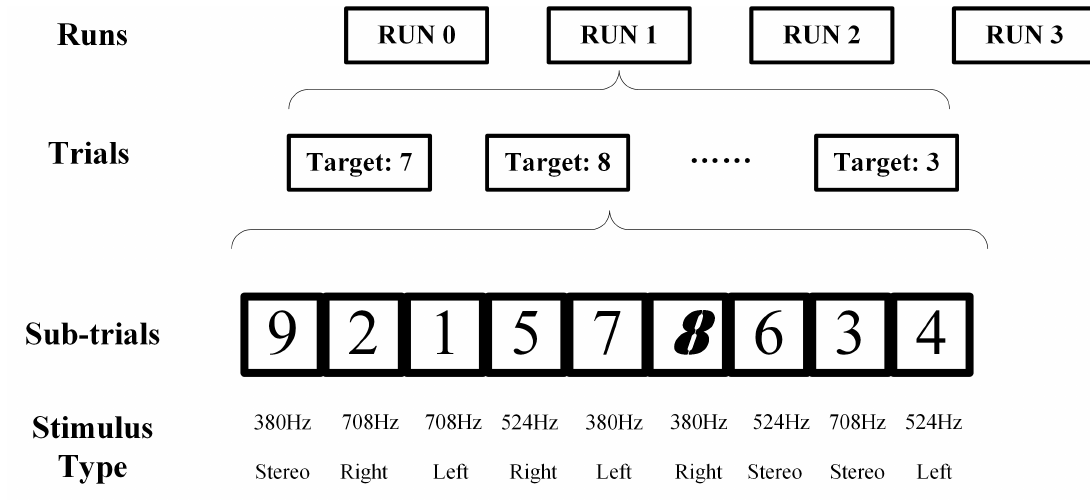
Figure 6. The experiment